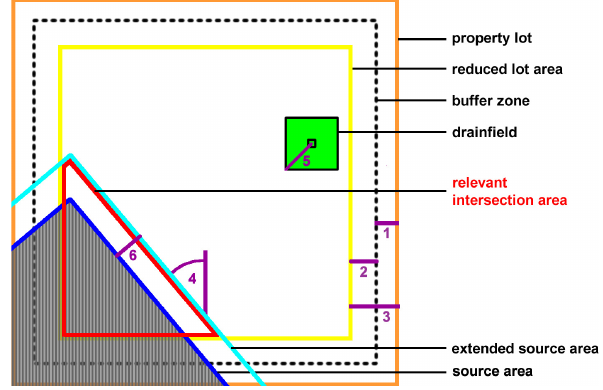
Fig. 4. Source area (grey hashed with blue frame) overlapping a lot (orange square) containing a drainfield (green) at a random position (compare to Fig. 3). The drainfield with the side length L drain can be located with uniform probability distribution anywhere in the lot with the constraint that the drainfield boundary is separated by a distance of at least L min (line 1) from the lot boundary due to reg- ulatory requirements. For the mathematical analysis, the drainfield is represented as a point and the lot area considered is reduced by half the length of the drainfield, L drain (line 2). Hence, the total re- duction at each lot boundary is the sum of both distances (line 3, Eq. 2), which leads to the yellow framed reduced lot area rele- vant for the analysis. Likewise, the source area is extended by L ext (line 6; Eq. 5), which depends on the distance of the drainfield cen- ter to its vertex ( L drain , line 5) and the flow direction (source area orientation) ( 8 flow , angle 4). The red framed area is the intersection area ( A intersect ) of the reduced lot area ( A lot red , yellow frame) and the extended source area (cyan frame). The probability p i that the drainfield overlaps with the source area in a given lot i is equal to the ratio of the red intersection area and the reduced lot area marked in